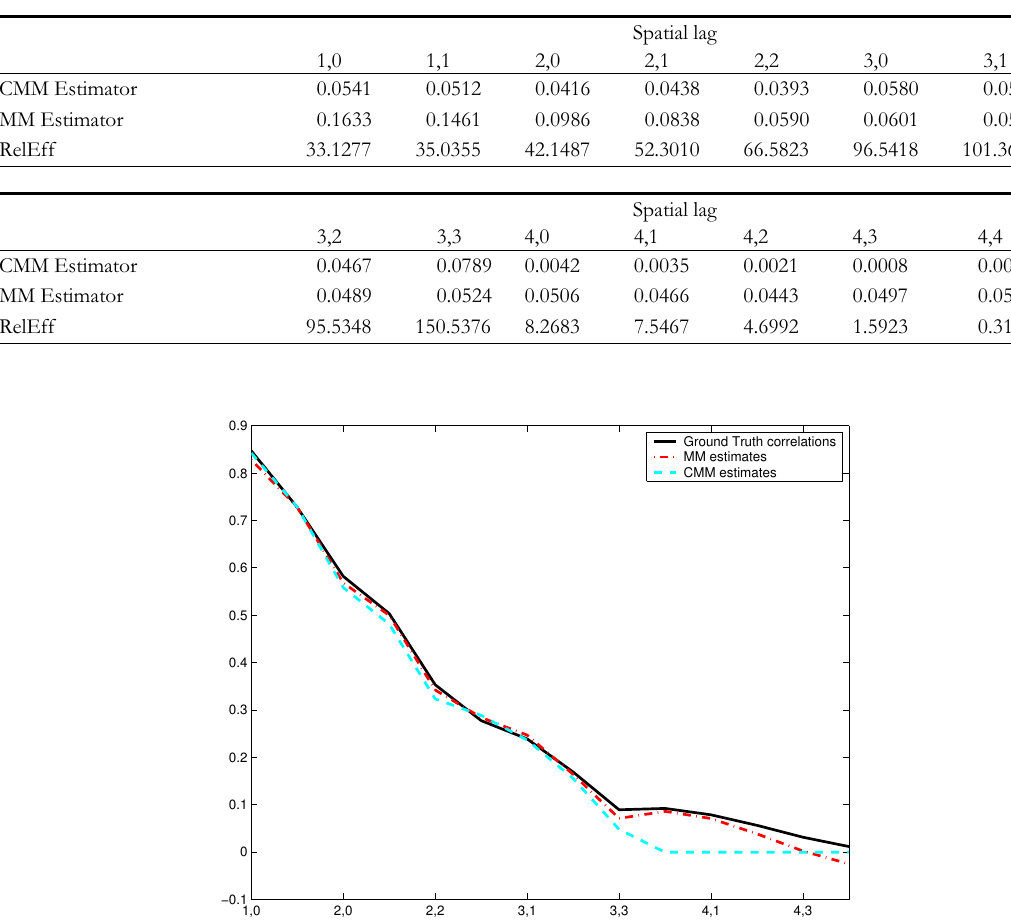
Root mean square errors for the classical (MM) and the corrected (CMM) method-of-moments estimators of spatial correlations at lags (1,0), ..., (4,4) under the weak dependency case. The relative efficiency between the considered estimators is reported using the RelEff statistic (see eq. (16))